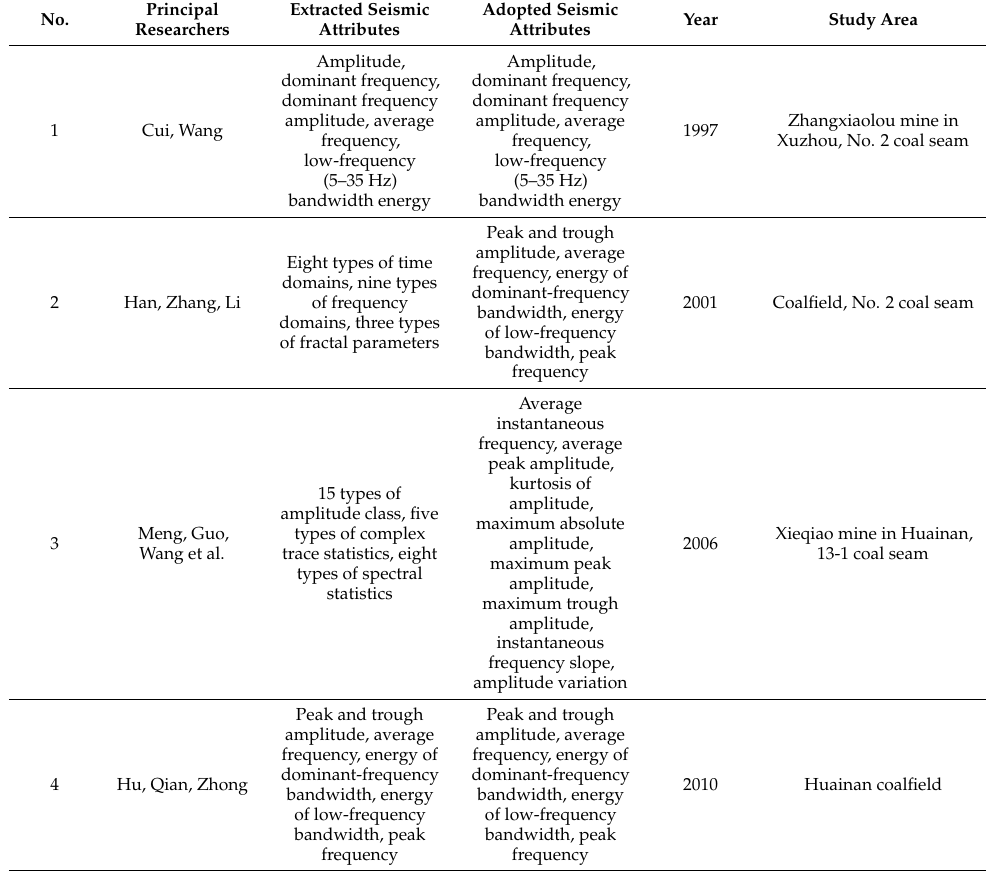
Table A4. Selection of seismic attributes in the representative study of seismic multi-attribute coal thickness